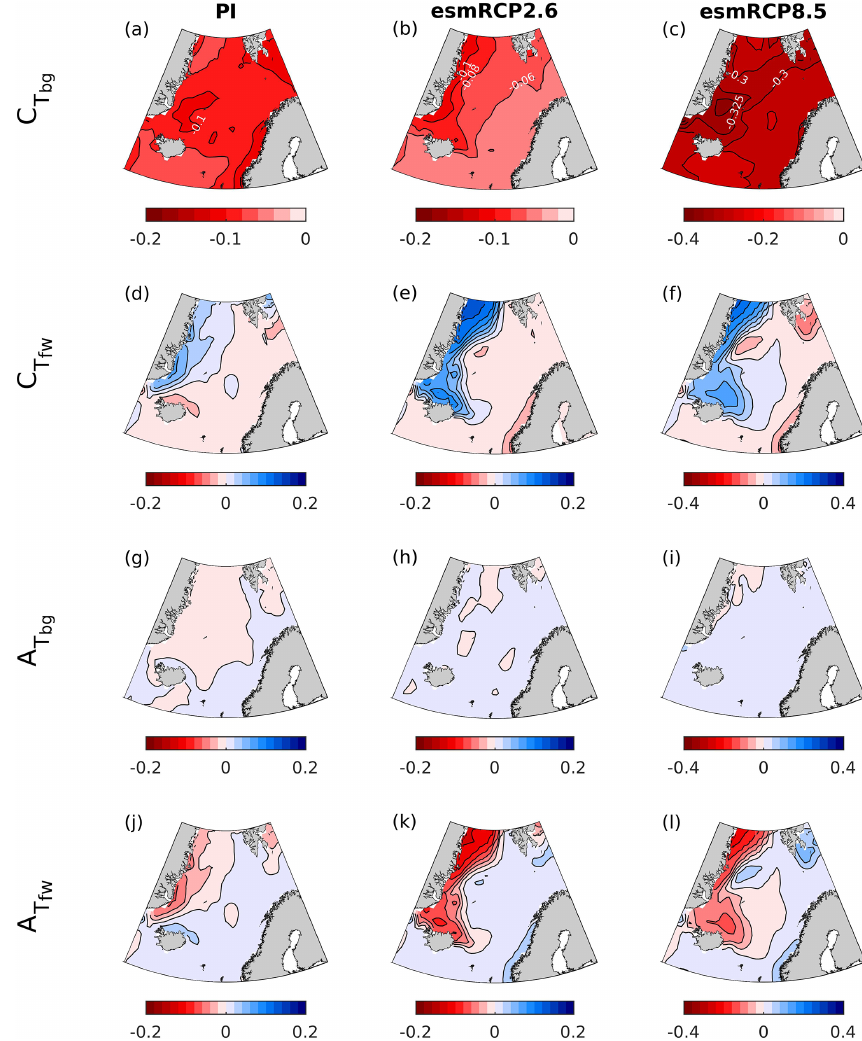
Figure 15. Contribution of the biogeochemical and freshwater components of C T and of A T ( A T